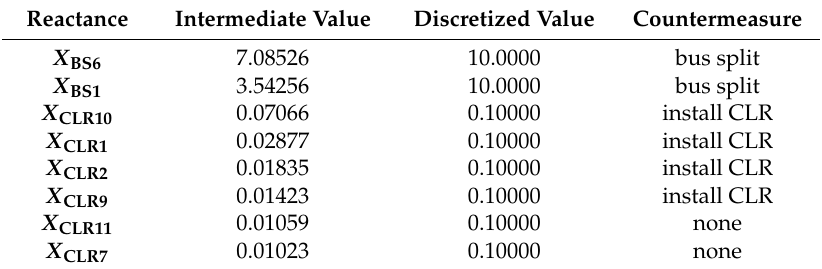
Table 10. X variables of the bus splitting and CLR candidates (Case 2).